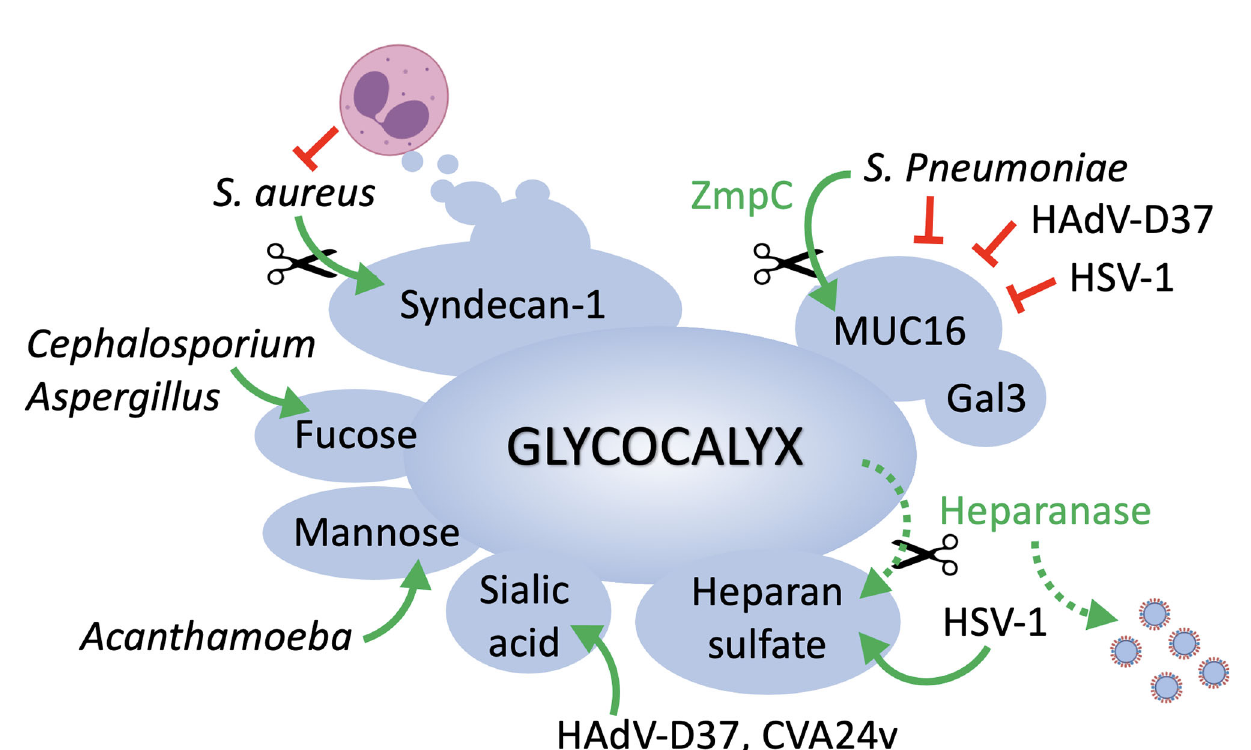
FIGURE 1 | The epithelial cell glycocalyx in ocular surface infection. MUC16 represents one of the fi rst barriers to the passage of bacteria and viruses at the ocular surface, and its function is reinforced by galectin-3. Pathogens must rely on the enzymatic removal of mucins (e.g., ZmpC) to access epithelial cells and cause disease. Pathogens such as S. aureus circumvent immune cell destruction by inducing shedding of syndecan-1 from the cell surface. HSV-1 uses heparan sulfate as a main entry receptor but also promotes heparanase biosynthesis in host cells to facilitate the release of viral progenies. Cell surface glycans containing sialic acid, mannose or fucose serve as receptors for viral, fungal and parasitic